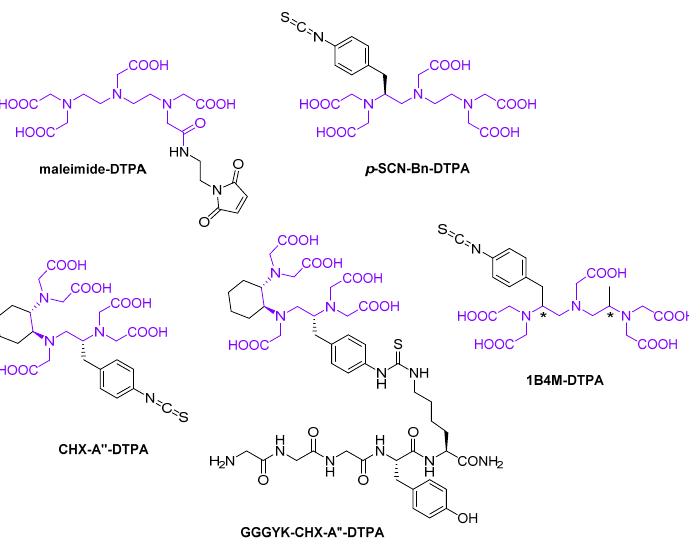
Figure 14. Diethylenetriaminepentaacetic acid (DTPA)-based synthetic chelators employed for labeling nanobodies with radiometals. DTPA substructure is highlighted in violet.